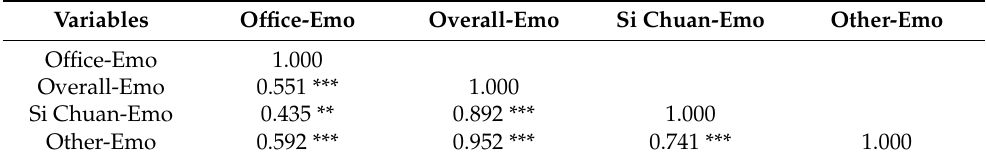
Table 4. Correlation